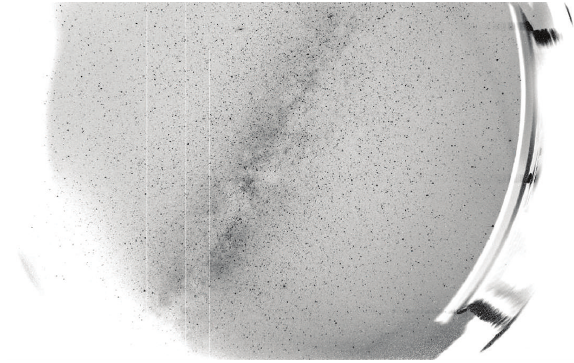
Figure 4: Sonneberg Observatory All-Sky 7k × 4k CCD camera, 10 minutes exposure, 4 × 4 binning (converted to negative).